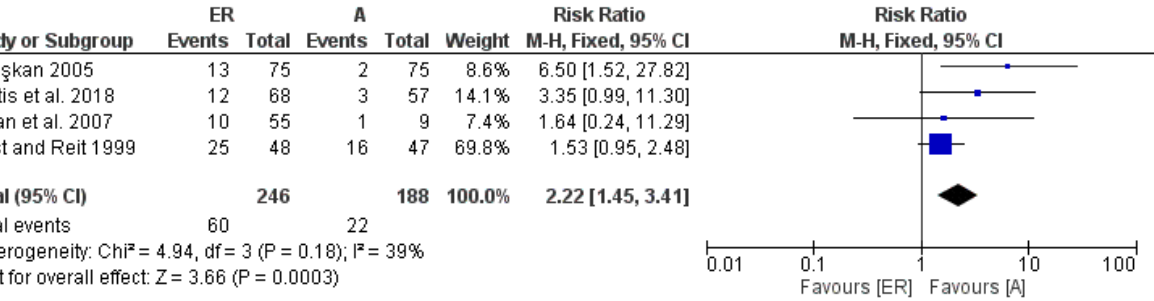
Figure 3. Forest plot of the fixed-effects model of the meta-analysis of the failure data within the 2- year follow-up. RR 2.22 [1.45, 3.41].